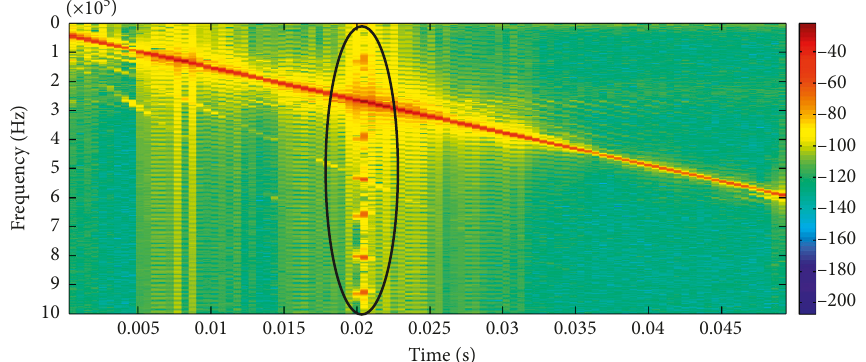
Figure 2: Time-frequency spectrum to determine optimum excitation